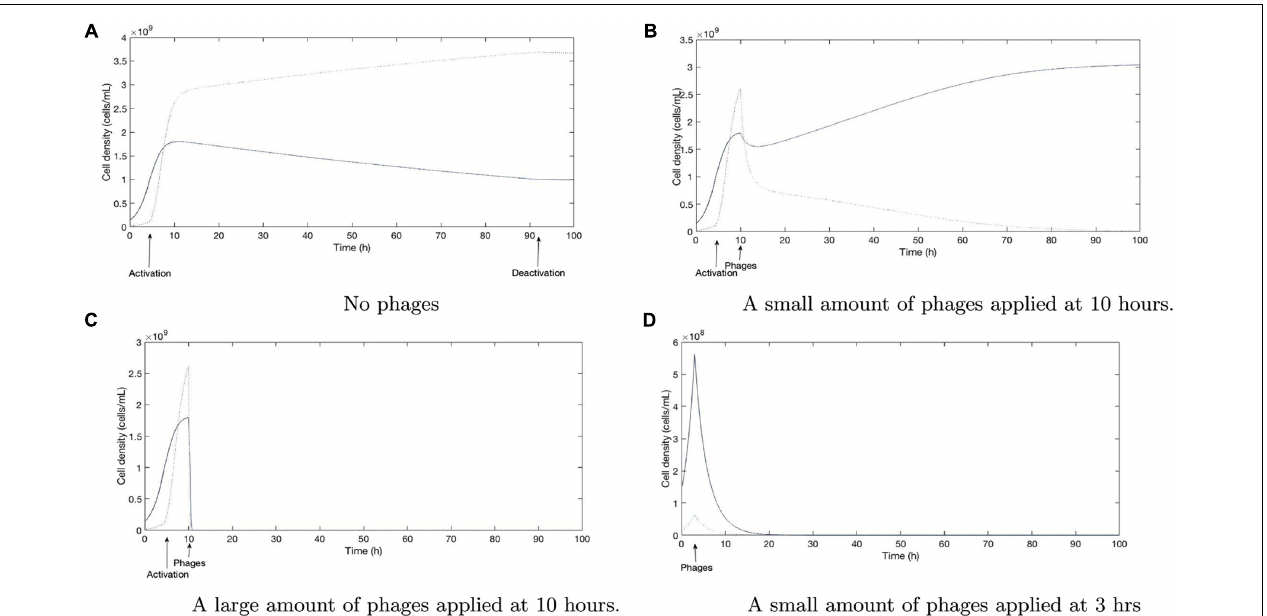
FIGURE 5 | Numerical simulations of the model (2): the solid line corresponds to the wild-type population and the dotted one to the QS-deficient double mutant. Parameter values used to produce this simulation (values of β i for i = 1, ... ,9) can be found in Remark 1 of the Supplementary Material. (A) Without phage therapy, a cheater that does not produce QS controlled exoproducts has a growth advantage over the wild-type population leading to mutant invasion. (B) With the same parameter set, adding a certain amount of phages after induction, results in an increase of the relative fitness of the wild-type—compared to the cheater. This increase of the percentage of the higher virulent wild-type is a potential risk to the host. (C) Applying a higher dose of phages after QS induction can eventually completely eradicate the bacteria. (D) Eradication is also possible when phages are applied before QS is